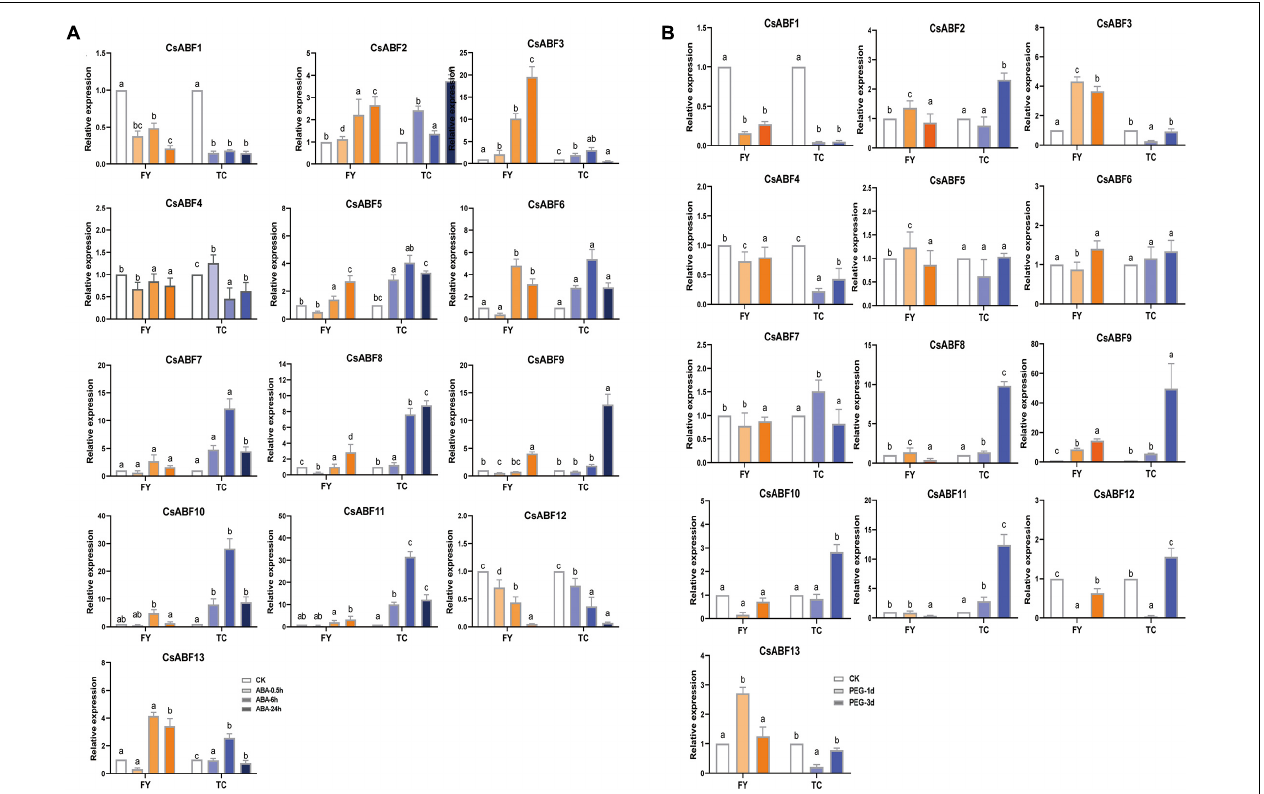
FIGURE 5 | qRT-PCR analysis the change of relative expression of CsABF genes. (A) Expression profiles of CsABFs in tea plant cultivars “Fuyun 6” (FY) and “Taicha 12” (TC) under exogenous ABA treatment. (B) Expression profiles of CsABFs in tea cultivars “Fuyun 6” (FY) and “Taicha 12” (TC) under drought stress. Different letters (a, b, and c) indicate statistical significance among treatments using one-way analysis of variance (ANOVA) test and a Fisher’s least significant difference (LSD) at the 5% significance